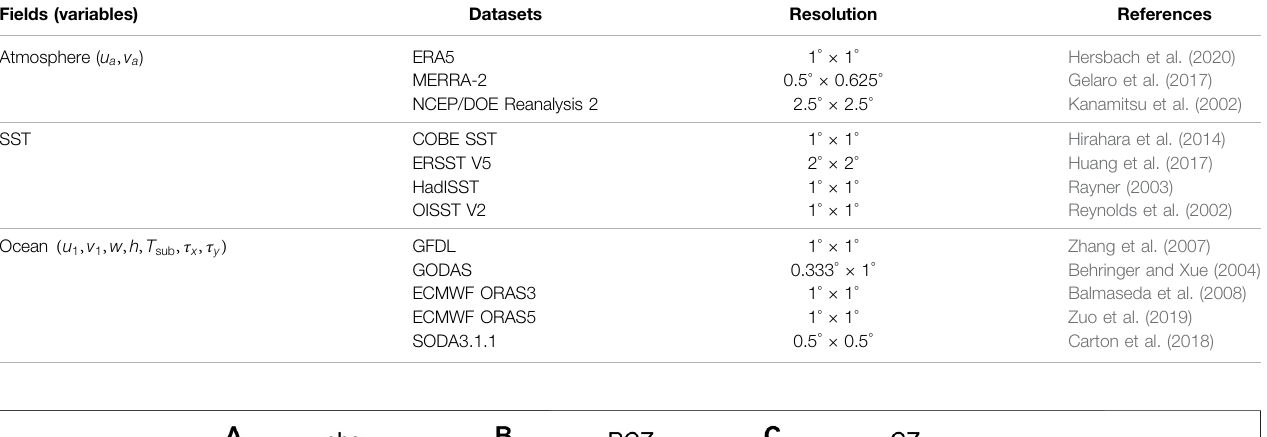
TABLE 1 | List of datasets used for model veri fi cation.